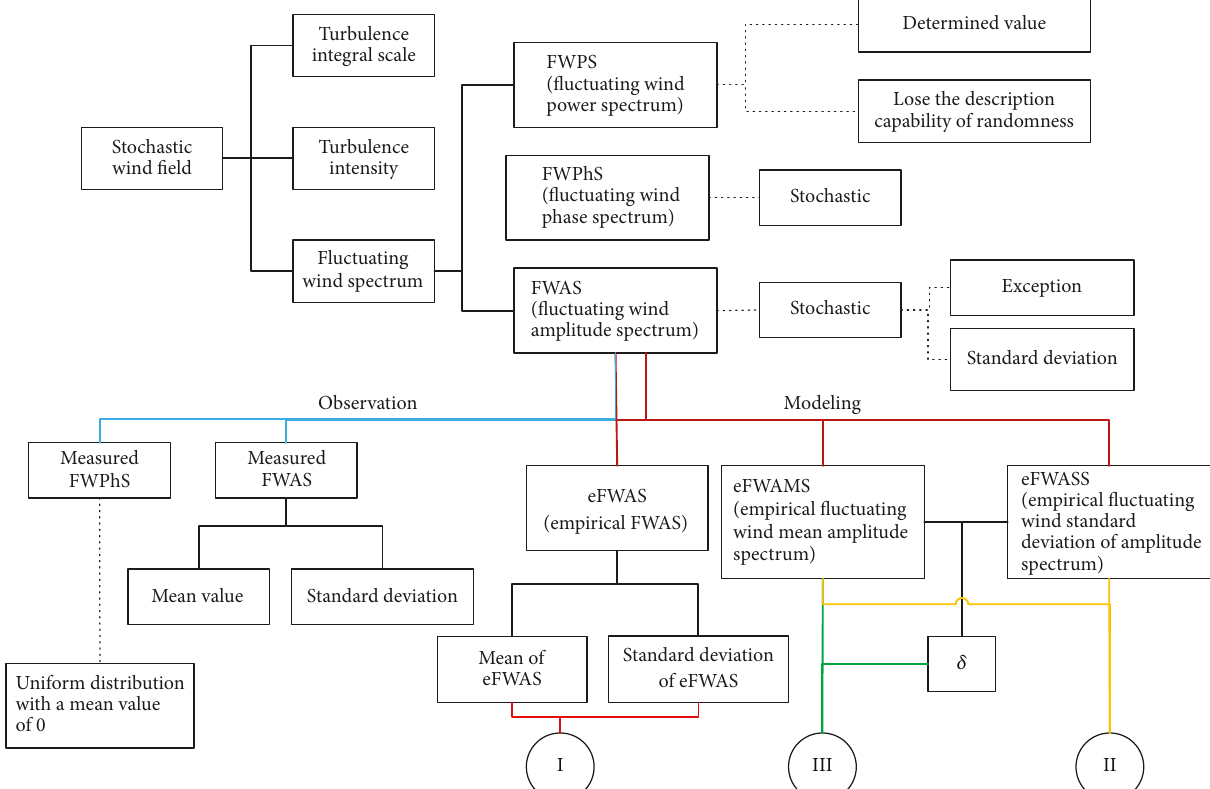
Figure 14: Empirical fluctuating wind model concept